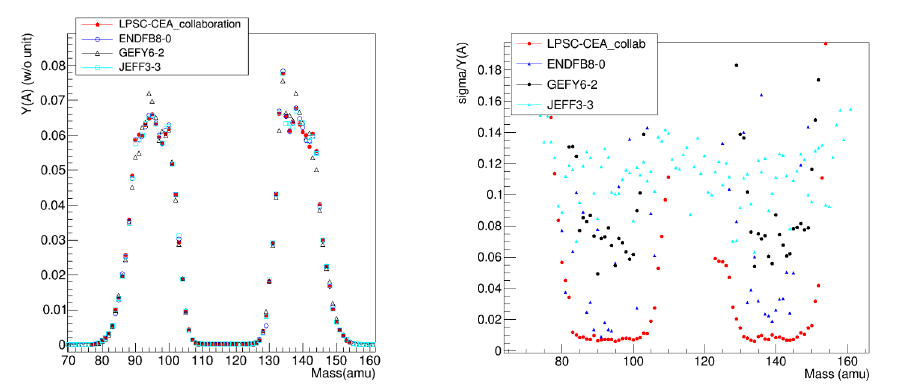
Figure 3. Preliminary results. (left) Mass yields evaluation proposed according to the maximum of Shannon’s entropy ( 4 th reference set ) in comparison to JEFF-3.3 [20] and ENDF / VIII.0 [21] libraries and the calculation from GEFY6-2 [3]. (right) Relative standard deviation of evaluated mass yields in comparison to those of evaluations or